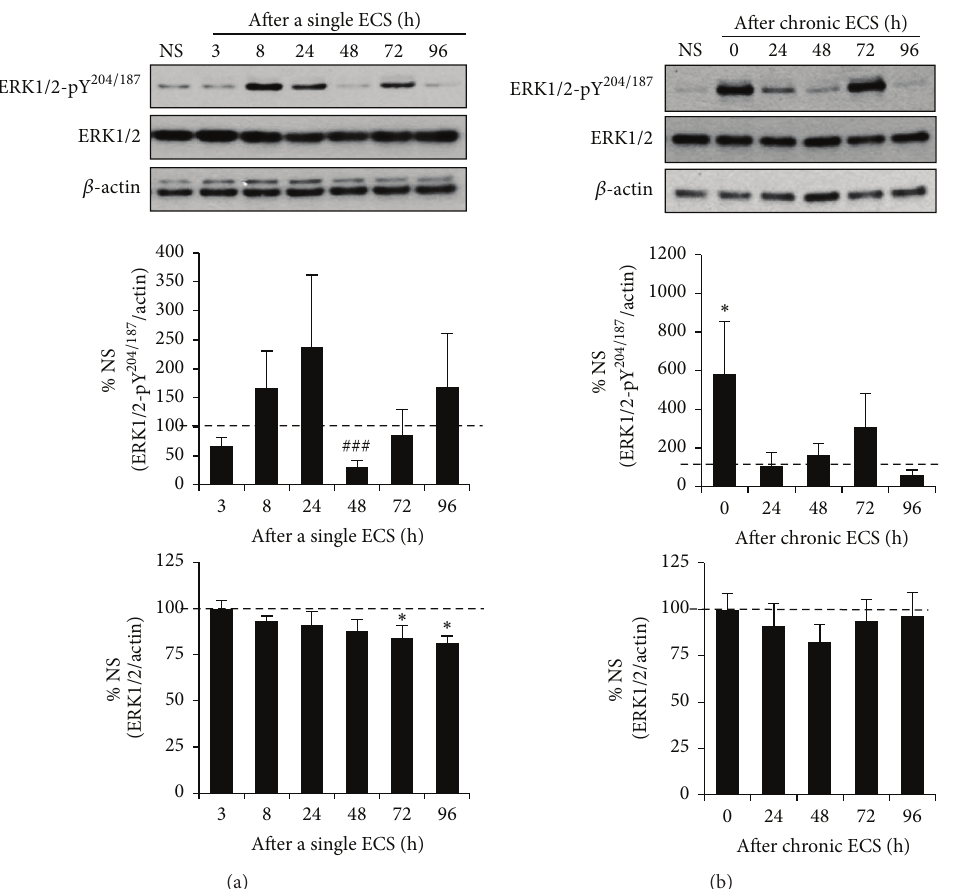
Figure 4: A single ECS and chronic ECS differently alter Tyr 204/187 -phosphorylation of ERK1/2 in the hippocampus. Immunoblot analysis for thephosphorylationofERK1/2atTyr 204/187 (Y 204/187 )andtotalERK1/2expressioninthehippocampalcrudemembrane(P2)fractionfollowing a single ECS ( 𝑛 = 5 rats per time point) (a) and chronic ECS ( 𝑛 = 6 rats per time point) (b). The ratio of the Tyr 204/187 -phosphorylated ERK1/2 band intensity over the 𝛽 -actin band intensity (top graphs) and the ratio of total ERK1/2 band intensity over the 𝛽 -actin band intensity (bottom graphs) were calculated per each time point and normalized to that of “no seizure” (NS) sham group. Data shown represent the mean band intensity ± SEM. (a) A single ECS transiently decreases the level of Tyr 204/187 -phosphorylated ERK1/2 in the hippocampus at 48 h ( ### 𝑝 < 0.005 , 𝑡 -test) and total ERK1/2 expression at 72–96 h ( ∗ 𝑝 < 0.05 ) following a single ECS. (b) Chronic ECS significantly increases the level of Tyr 204/187 -phosphorylated ERK1/2 at 0h following chronic ECS ( ∗ 𝑝 < 0.05 ) but has no effect on total GluN2B expression in the